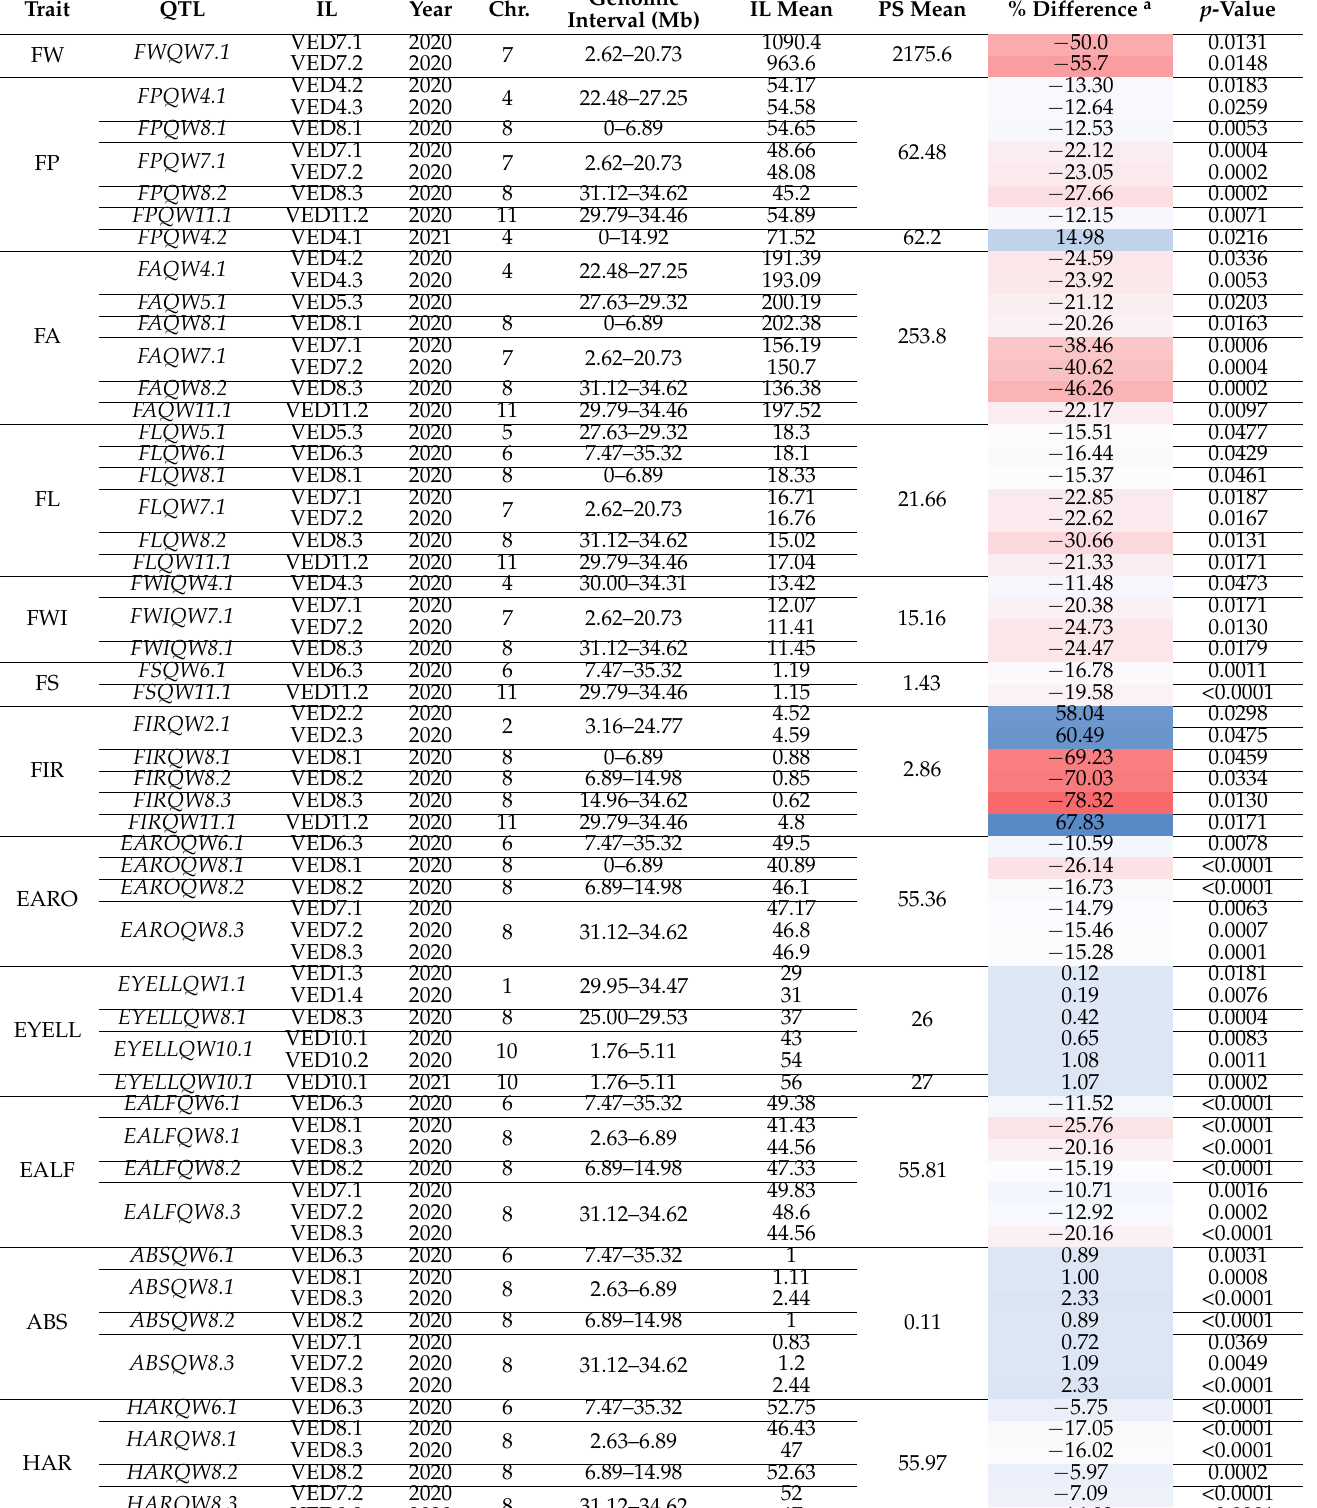
Table 2. Summary of the QTLs mapped in the population for the quantitative